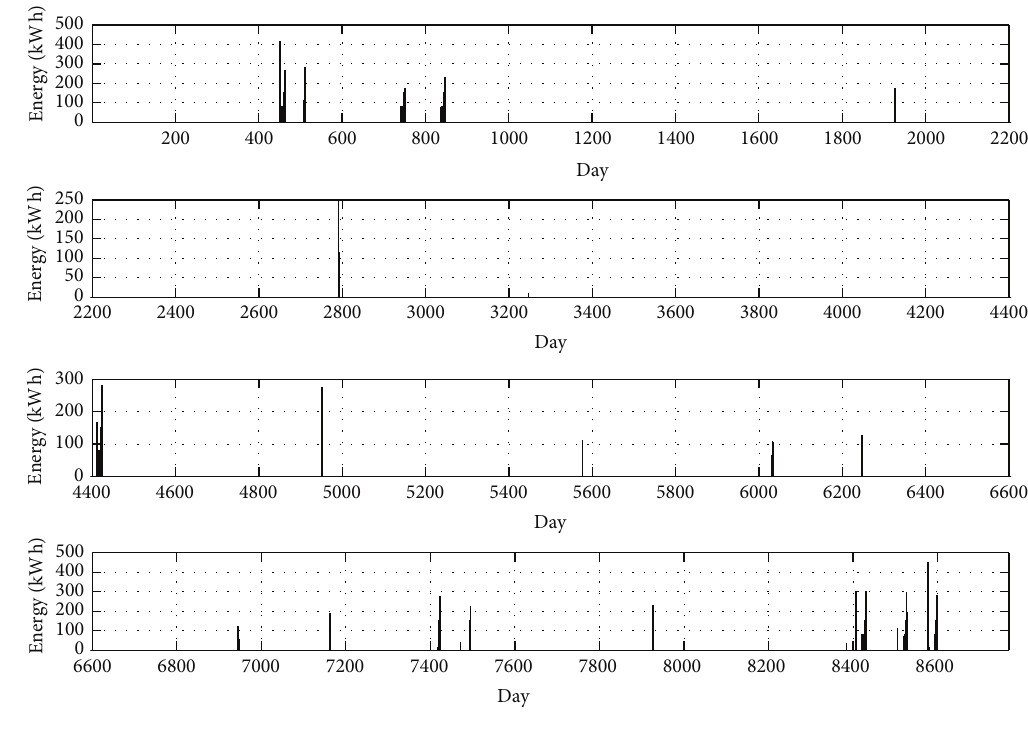
Figure 9: Loss of load days for the designed PV